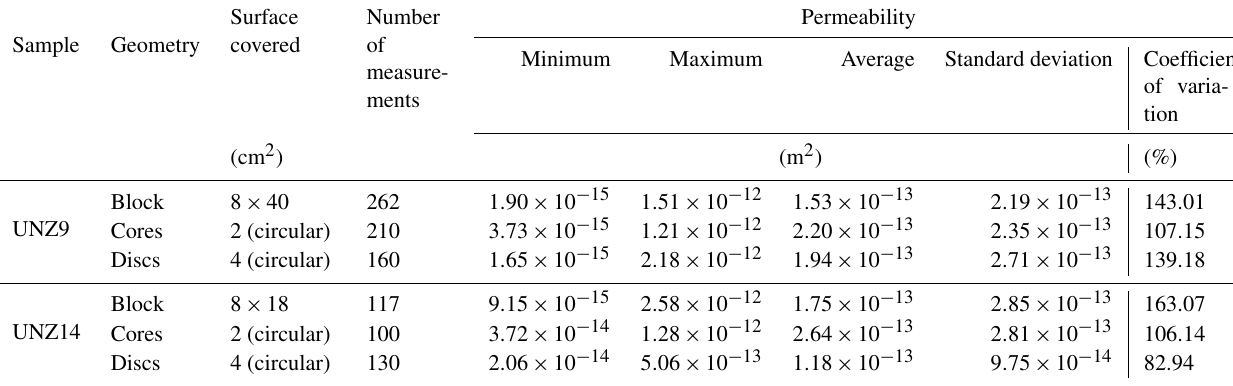
Table 2. Planar block surface unconfined permeability estimates for isotropic (UNZ14) and anisotropic (UNZ9) blocks with values compared to those determined on core and disc samples (note that the UNZ9 core and disc measurements encompass those made on UNZ9a and UNZ9b).